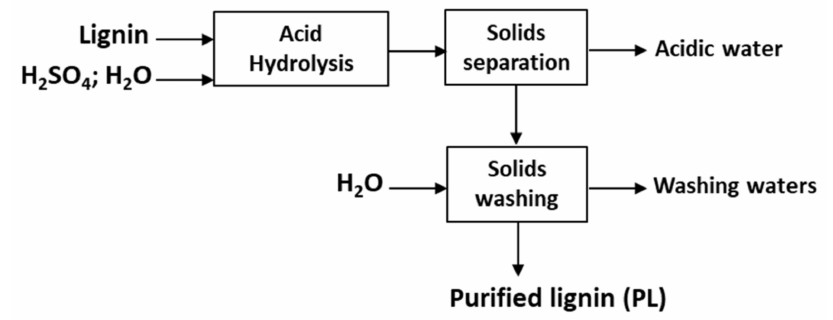
Figure 11. Schematic representation of the acid hydrolysis